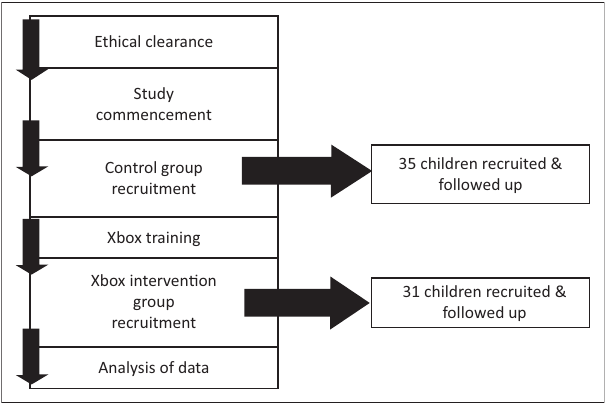
FIGURE 1: Flow chart summarising recruitment of study population.